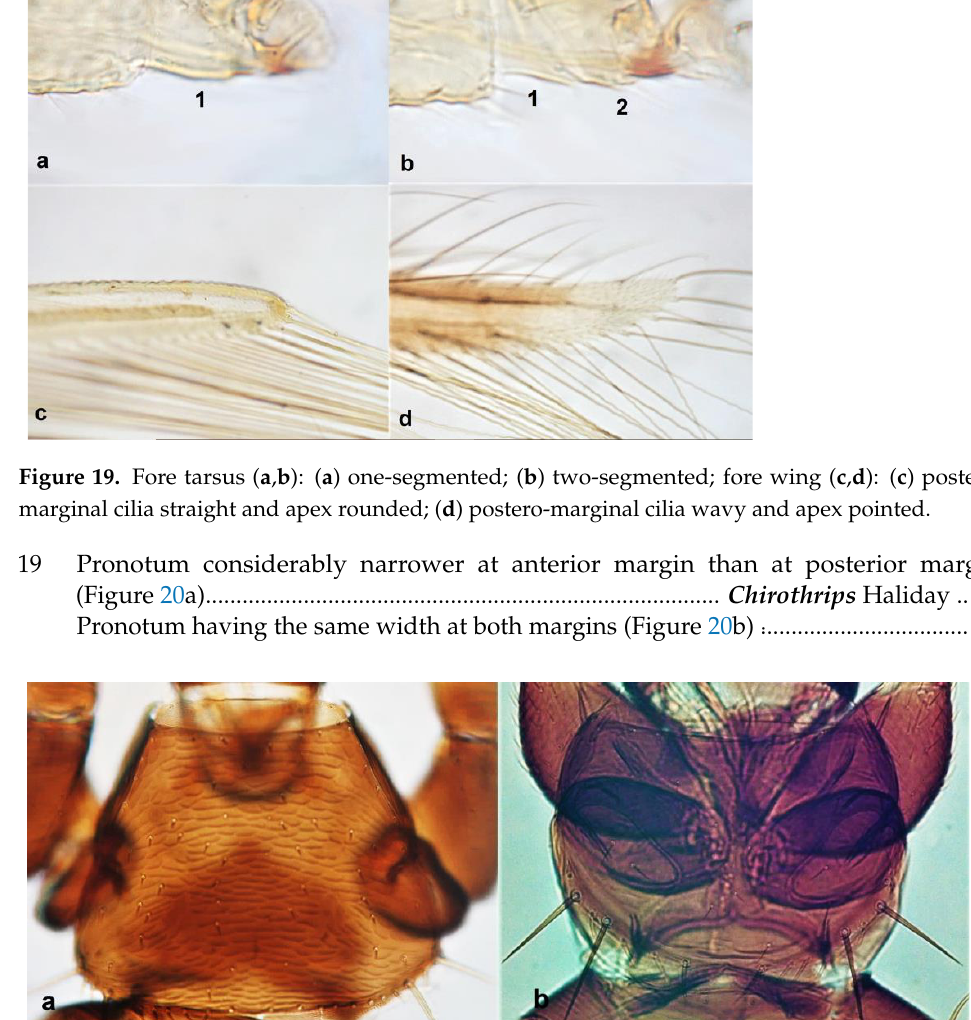
Figure 21. Antennal segment II showing outer edge ( a , b ): ( a ) nearly straight; ( b ) at an obtuse angle from the base of the segment; antennal segment IV ( c , d ): ( c ) with a forked sense cone; ( d ) with a simple sense cone. 21 Antennal segment II with the outer edge nearly straight (Figure 21a); antennal segment IV with forked sense cone (Figure 21c); antennal segment VII longer than VIII; males usually macropterous ………………….. Chirothrips meridionalis Bagnall Antennal segment II with the outer edge at an obtuse angle from the base of segment, creating a tip with bulge (Figure 21b); antennal segment IV with simple sense cone (Figure 21d); antennal segment VII shorter than VIII; males micropterous …………………………………………………………… Chirothrips manicatus Haliday 22 Abdominal segment X bearing a pair of thorn-shaped setae (Figure 22a) …………………………………………………………………… Limothrips Haliday .. 23 Abdominal segment X without thorn-shaped setae (Figure 22b) …………………… 24